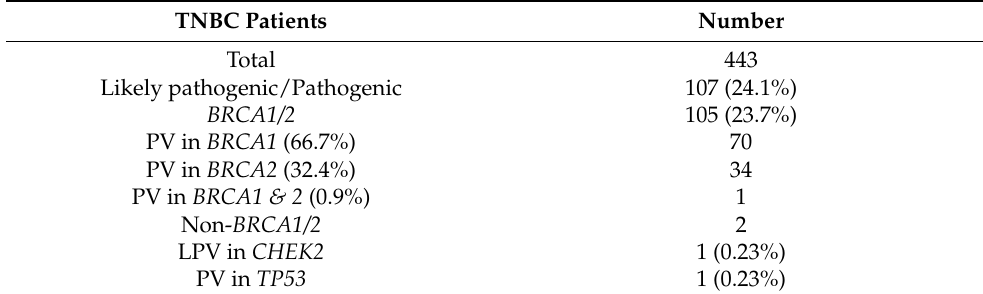
Table 3. Likely pathogenic/pathogenic variants in BRCA1/2 and non- BRCA detected in triple- negative breast cancer